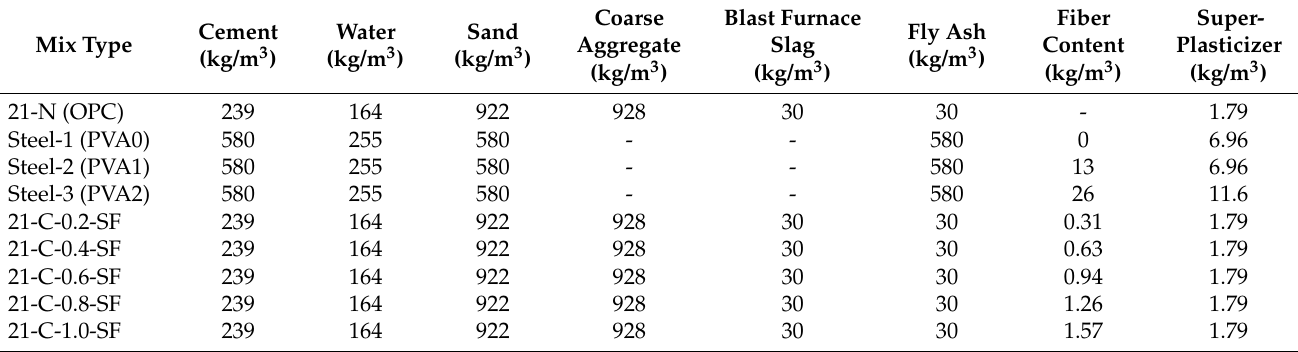
Table 3. Concrete mix proportions.